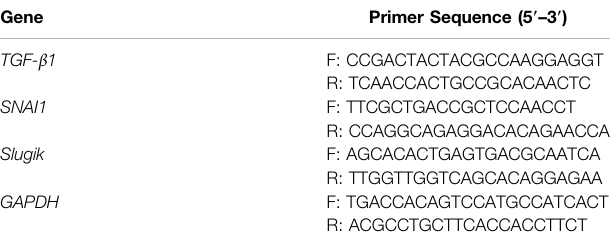
TABLE 1 | Primers used in this study. Gene Primer Sequence (5 9 – 3 9